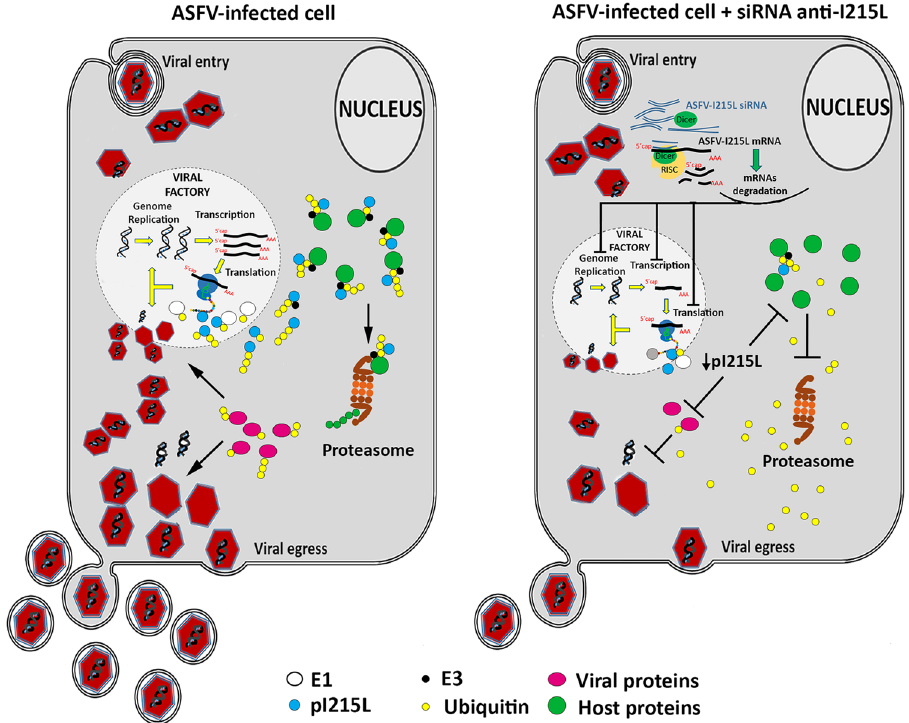
Figure 5. Proposed working model of the role of pI215L during ASFV infection. Once ASFV enters the host cell, different host mechanisms are subverted in other to generate a productive infection. By encoding an E2 ubiquitin-conjugating enzyme (pI215L), ASFV hijacks the cellular ubiquitin-proteasome system modulating the function and subcellular localization of host proteins and its own proteins. By controlling the ubiquitination status of the cellular proteins, viruses are able to evade host antiviral responses by targeting proteins to proteasomal degradation and to modulate the activity of viral proteins in different mechanisms. Our model suggests that by downregulating I215L expression, a reduction in the abundance of ubiquitin-tagged proteins occurs and consequently causes an inhibition of several crucial viral processes (e.g. genome replication, gene transcription, translation, egress), as well as host pathways (e.g. antiviral immune response,